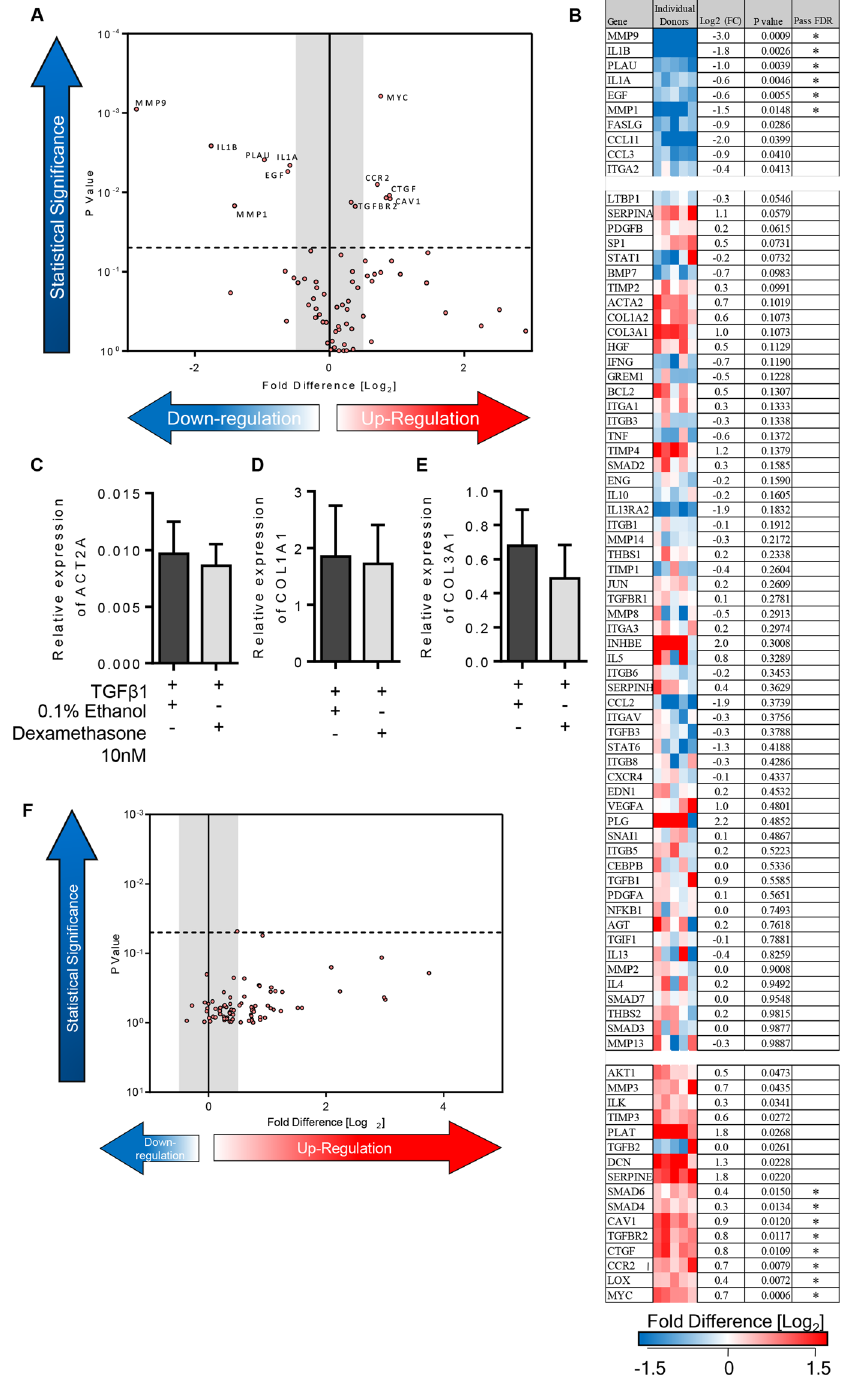
Figure 6. The effects dexamethasone on TGF β 1-induced fibrotic gene expression. ( A ) Volcano plot displaying the 11 differentially expressed genes following treatment with dexamethasone for 7 days in comparison to TGF β 1 alone, n = 5 donors. Treatment with dexamethasone resulted in the upregulation of 6 genes and downregulation of 8 genes passing 5% false discovery analysis with John D. Storey adjusted p value < 0.05 and absolute value of Log 2 (FC) greater than 0.5, depicted by the dotted lines and grey shaded area (results are mean of 5 individual donors). ( B – D ) Relative expression of ACT2A, COL1A1 and COL3A1 were unchanged when the TGF β 1-stimulated tissue was cultured with dexamethasone (10 nM) ( F) Similarly, 0.1% ethanol (vehicle control for dexamethasone) did not affect TGF β 1-stimulated fibrogenesis highlighted in the volcano plot identifying the gene expression of 84 fibrotic